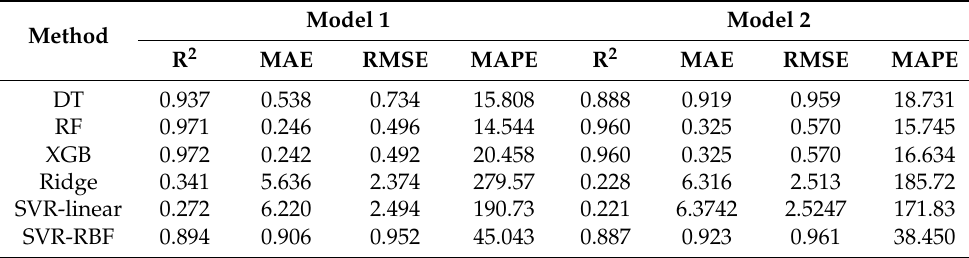
Table 9. Validation results of the spill mass prediction